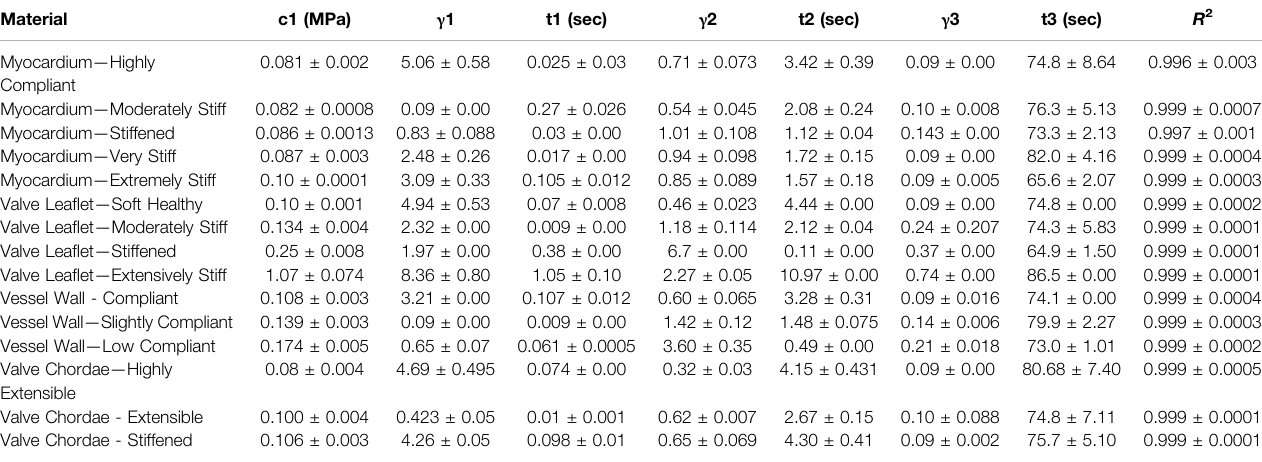
TABLE 6 | Nonlinear viscoelastic incompressible Neo-Hookean fi t to J750 Digital Anatomy Printer (DAP) Structural Heart Materials. Table of compressible nonlinear viscoelasticcompressibleNeo-HookeanparametersfortheStructuralHeartmaterialsalongwiththe R 2 valuesofthe fi tbetweentheconstitutivemodelandexperimental data (n = 4 specimens per material). Only the second optimization run with the bounds being the mean parameters from the fi rst optimization run ±10% of the mean is